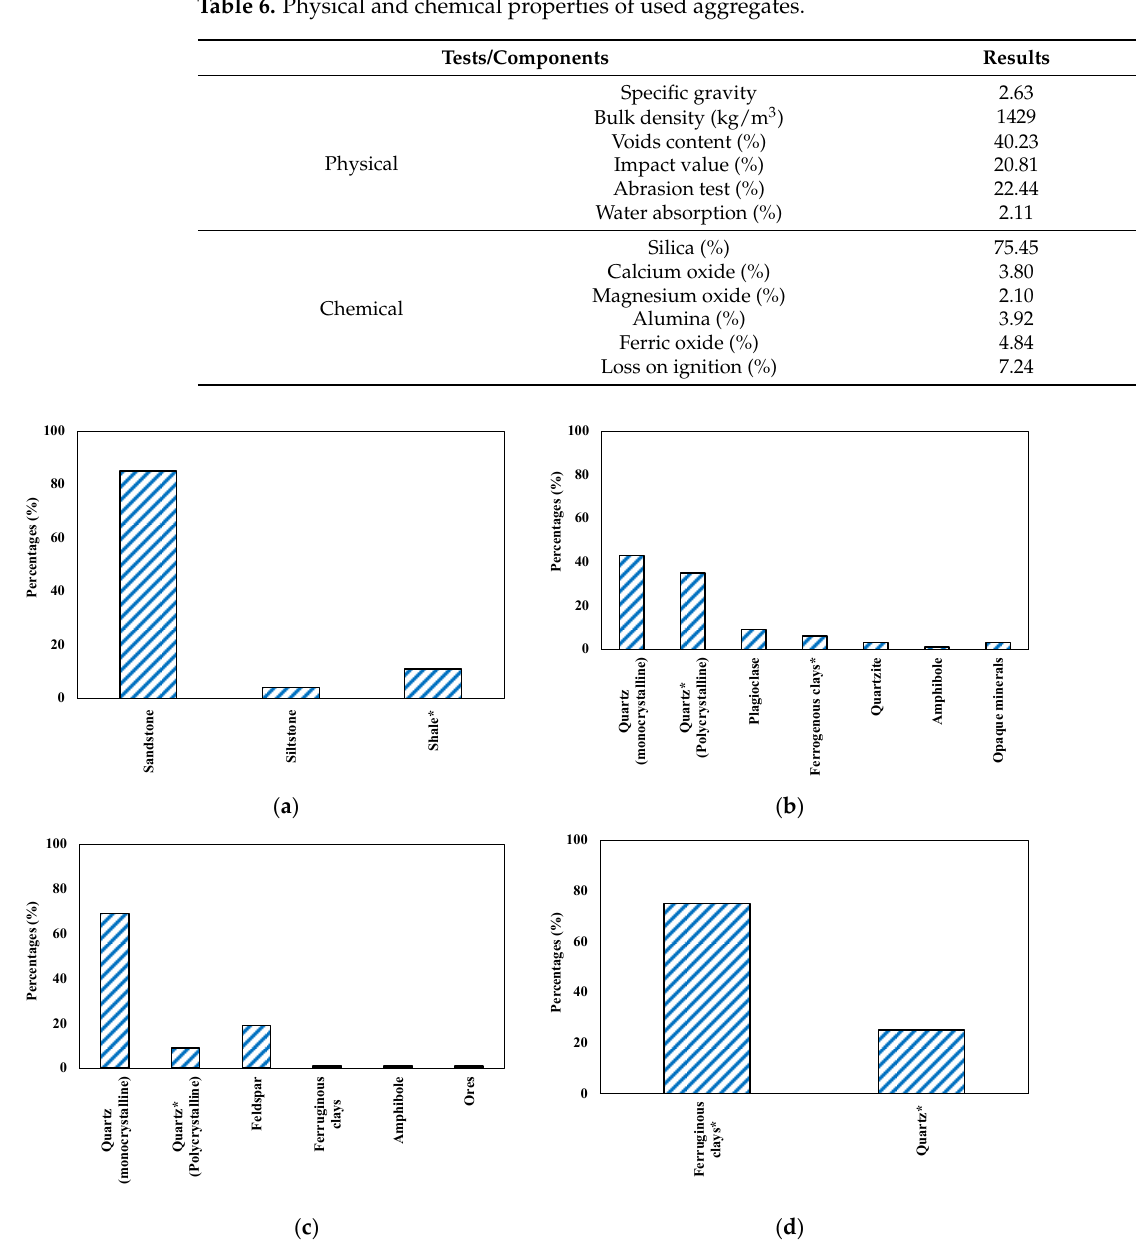
Table 6. Physical and chemical properties of used aggregates.